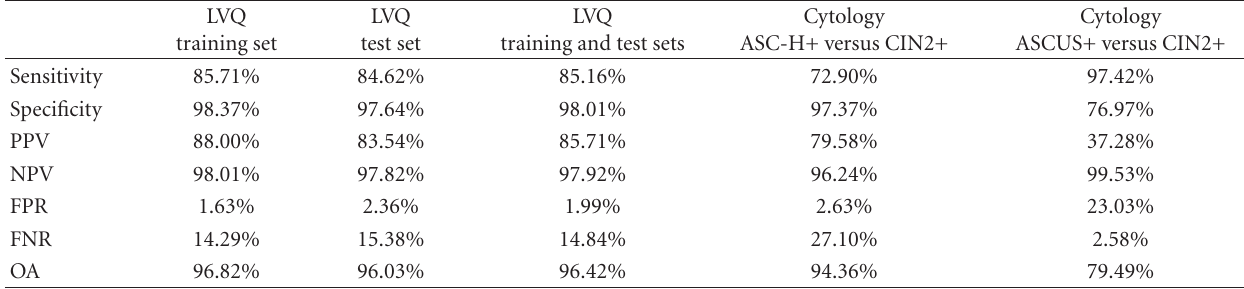
Table 4: Performance of the LVQ NN for the training set, test set and in total, and Cytological performance in our material.